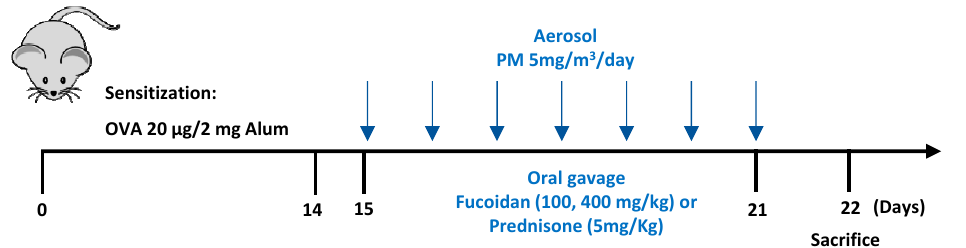
Figure 13. Experimental plan for PM-exacerbated allergic airway inflammation in OVA-sensitized